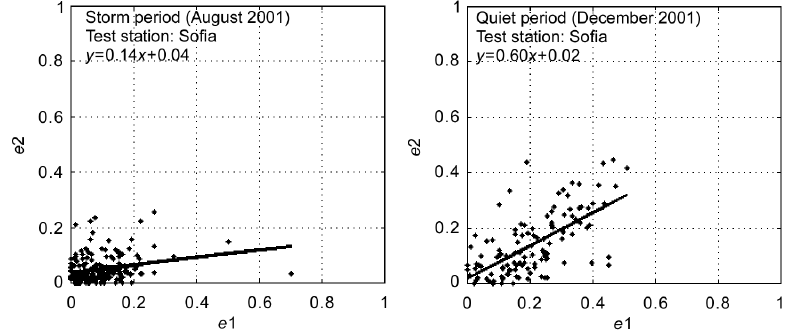
Fig. 5. The scatter plots of e 2 versus e 1 for the two simulated time periods. The best-fit line and its equation are also shown.